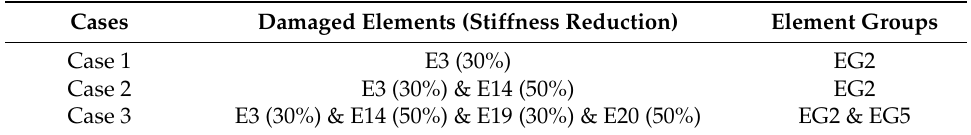
Table 5. Prediction results of the Bayesian neural